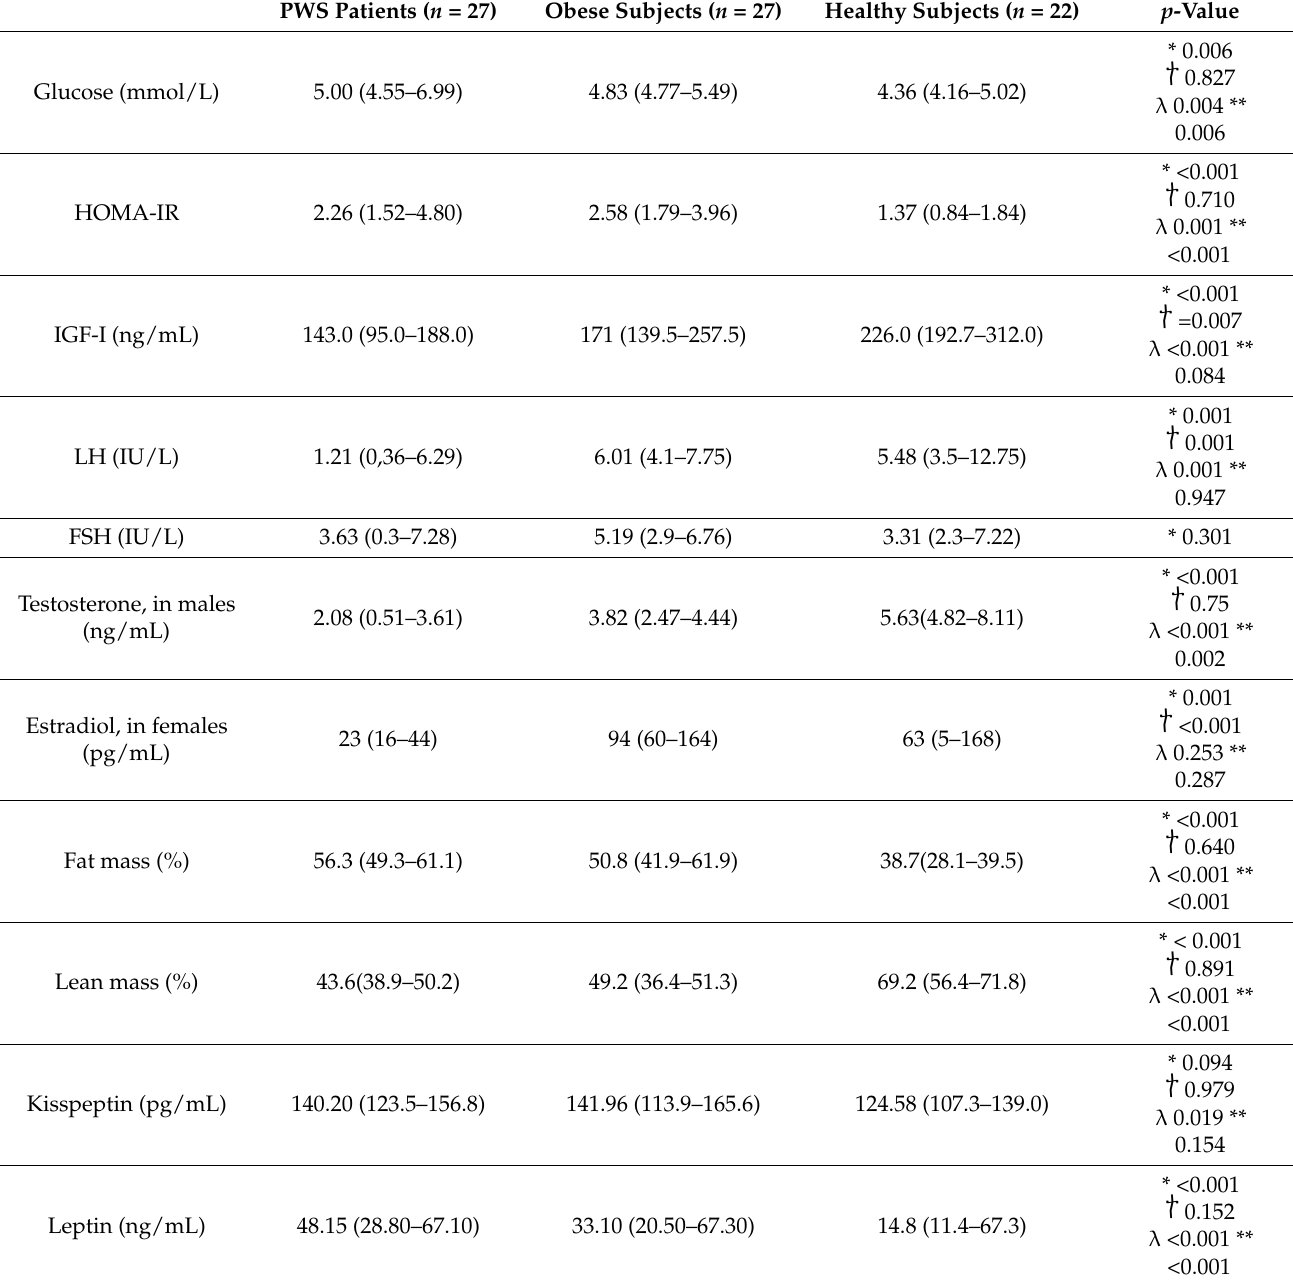
Table 1. Baseline characteristics of participants.